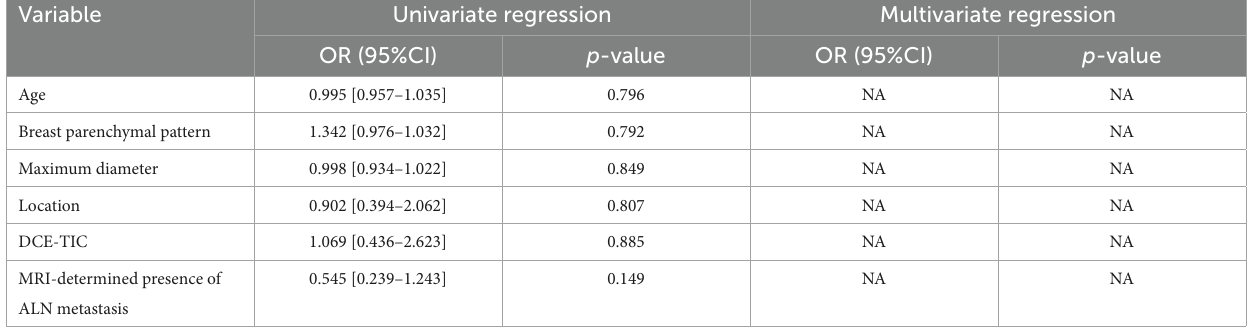
TABLE 3 Univariate and multivariate logistic regression analysis of clinical risk factors for distinguishing luminal and non-luminal molecular subtypes of invasive breast cancer.